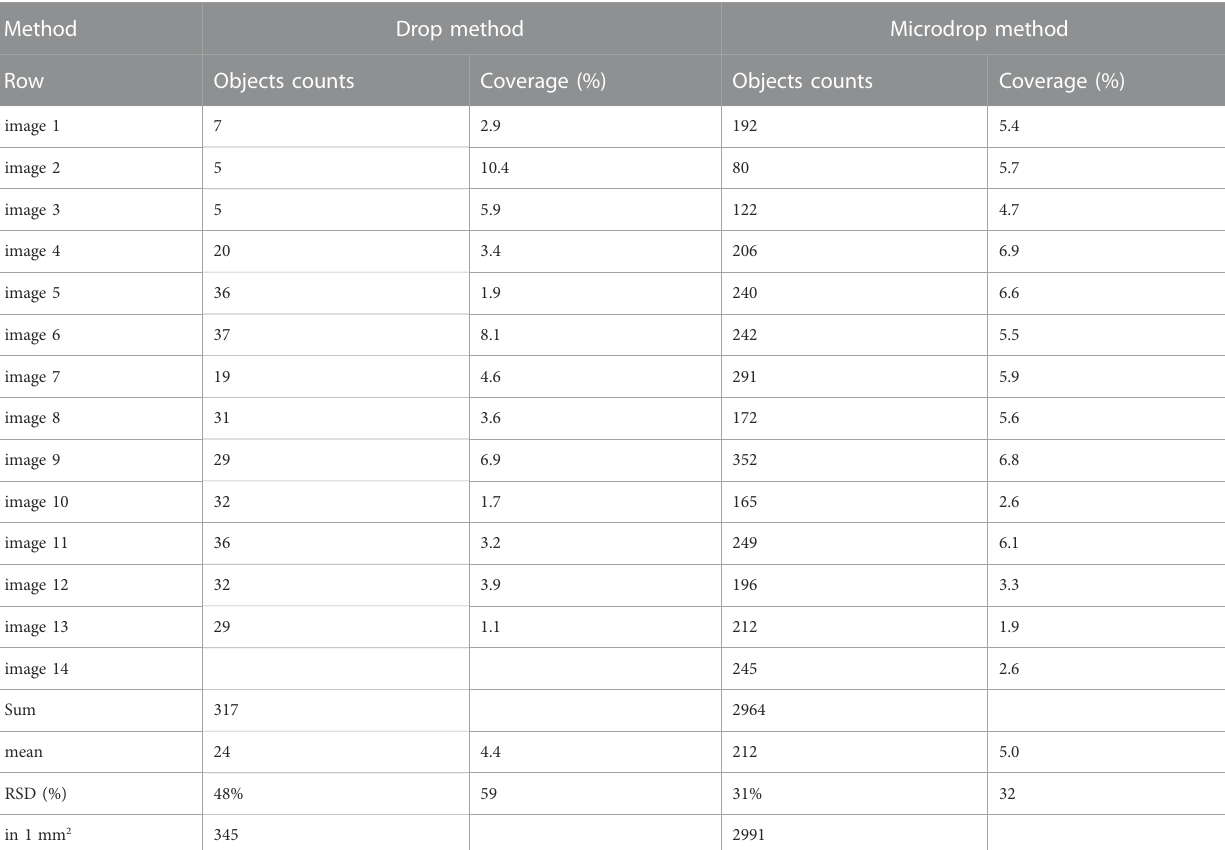
TABLE 1 Results of the image processing analysis for representative images collected on the samples obtained using the drop and the micro-drop deposition methods, respectively. Full results are given in (Supplementary Table S1). Method Drop method Microdrop